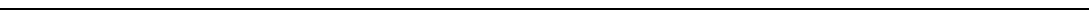
Fig. 2 Inactivation and desensitization of PIEZO1 can be reset by outward permeation. Repetitive pressure stimulations desensitize PIEZO1 at − 60 mV ( a ) but not at + 60 mV ( b ). Note the decreased peak current and low peak/steady-state current ratio at − 60 mV. c Alternating pressure pulses at − 60 mV and + 60 mV abolishes desensitization and prevents PIEZO1 from entering a non-inactivating state. d Peak currents in a (negative pulses), b (positive pulses) and c (negative pulses) were normalized to the fi rst response and plotted against time. Desensitization is absent at alternating voltages. e Three pressure pulses (P1, P2, P3) at − 60 mV were applied to patches expressing PIEZO1 to drive the channel into a desensitized state, followed by one positive pressure pulse (P4) at + 40 mV. The sequence was repeated twice. Outward permeation (P4) recovers PIEZO1 initial current (P1), as shown by the ratio of P5/P1, shown in h ). f The stimulation sequence in e was repeated in absence of pressure at P4. The recovery from desensitization does not occur at + 40 mV in absence of permeation. g The same protocol in Fig. 2e was repeated with the ionic concentrations shown. Inward currents fl ow at P4 at + 40 mV. No recovery from desensitization is observed at P5, underlining the importance of outward permeation for resetting channel kinetics. h The P5/P1 ratio for e (white, n = 10), f (green, n = 13), and g (orange, n = 7) are shown and are statistically different (Anova, Dunnett ’ s post-hoc test, d F = 18, white vs green P = 0.00004, white vs orange P = 0.001). i Raw amplitude levels for P4 in f (green) or g (orange) are statistically different (Student ’ s t- test P = 0.00003, d F = 20). j Paired pulses protocol of a pressure stimulus at + 60 mV preceded by either a pressure step at − 60 mV (light blue) or at + 60 mV (black). The direction of the fi rst current stimulus affects the amplitude and the time course of activation of an identical second step at + 60 mV. k The rise time and the amplitude ratio of the second stimulus at + 60 mV in j are compared. The interval between the two stimuli was either 2 or 30 s. Both parameters are signi fi cantly different (Students t -test P < 0.001, n = 28, d F = 26). The data are shown as mean ±